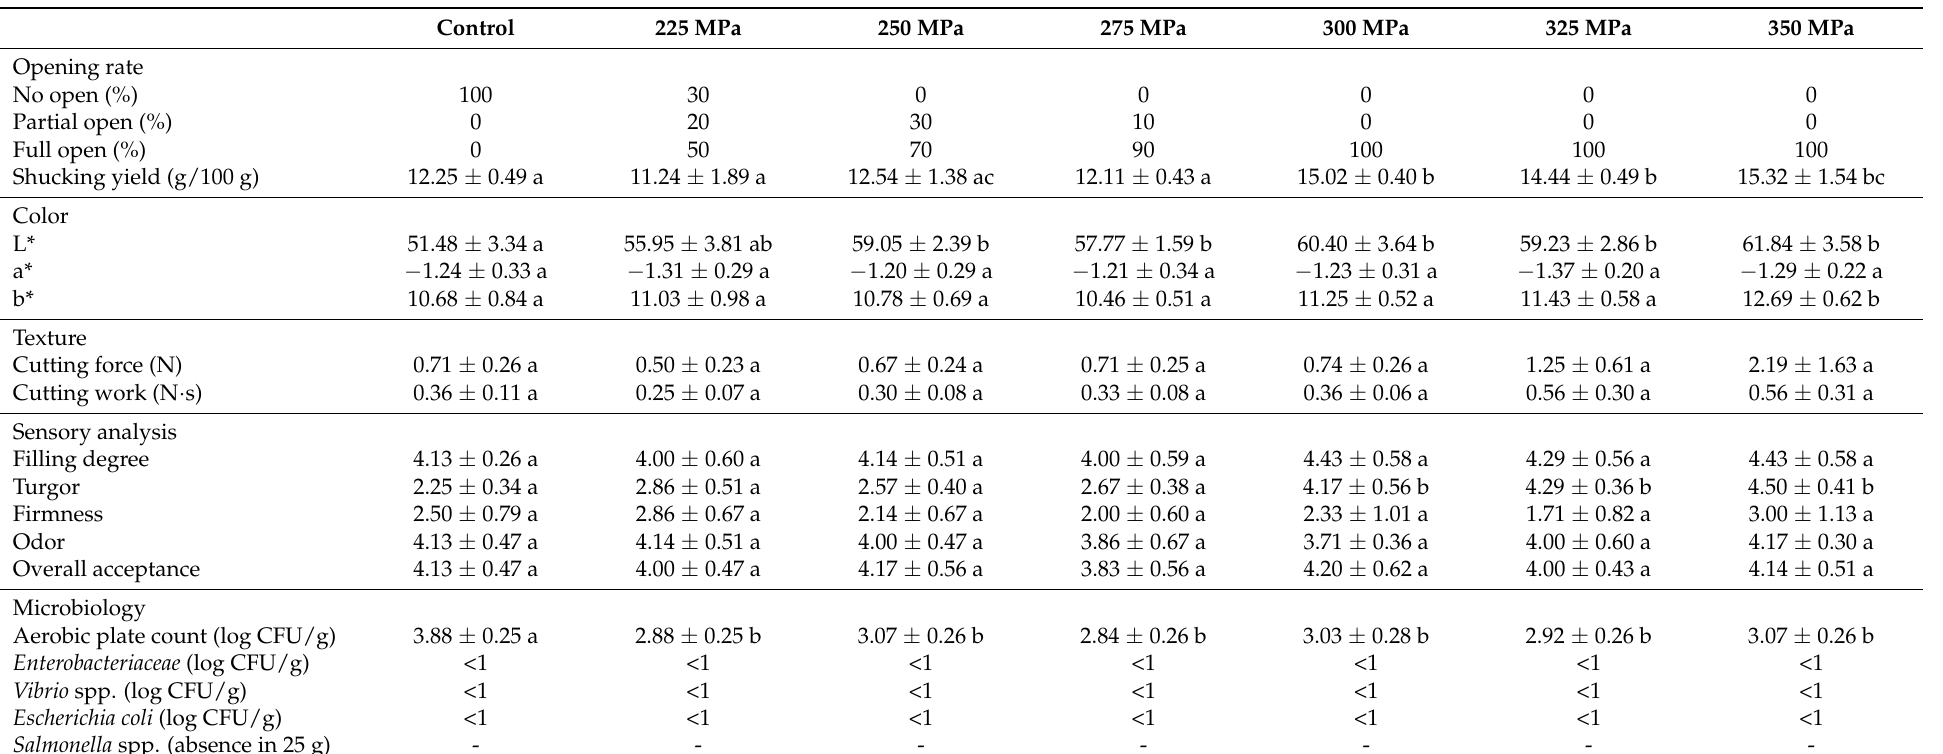
Table 2. Results obtained for untreated (control) and HPP oysters (225 to 350 MPa for 2 min) in terms of opening rate, shucking yield, color, texture, sensory characteristics and microbial